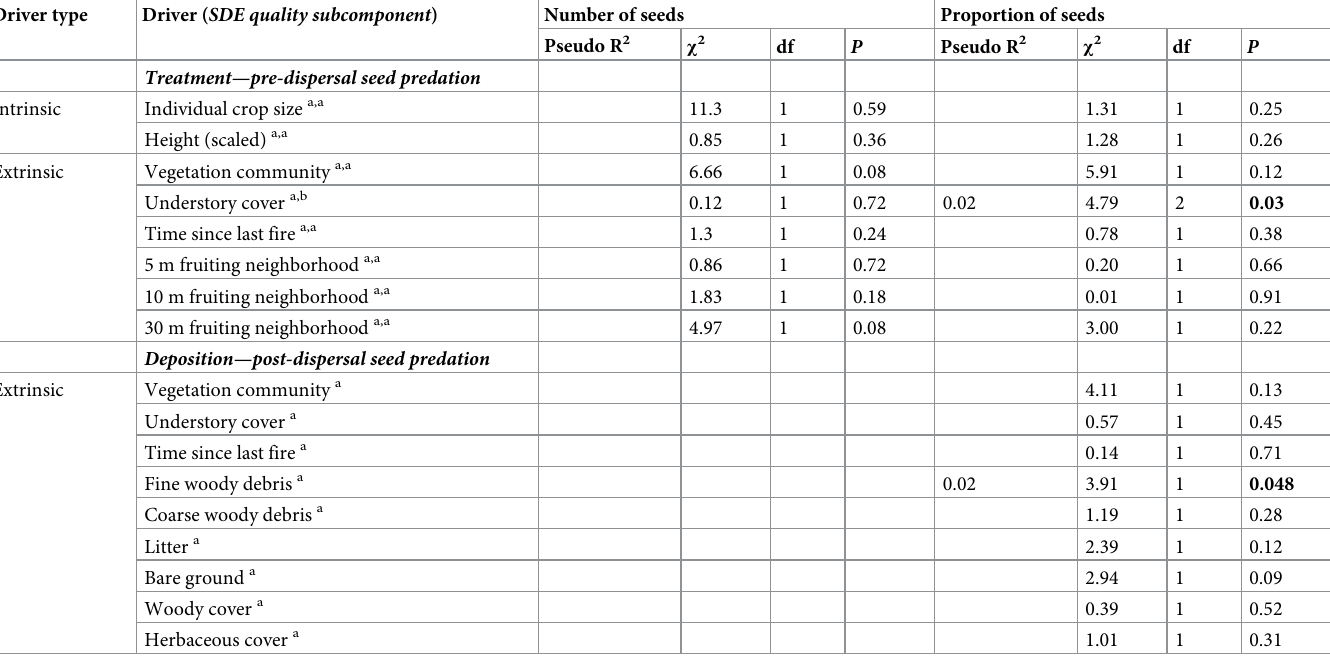
Table 2. Results testing for the significance of intrinsic and extrinsic drivers on treatment (pre-dispersal predation) and deposition (post-dispersal predation) sub- components of seed dispersal effectiveness quality (number and proportion). Model comparisons evaluated with type II likelihood ratio χ 2 tests are identified by letter codes after each driver for the number and proportion of seeds, respectively. P values in bold indicate a significant effect ( α =